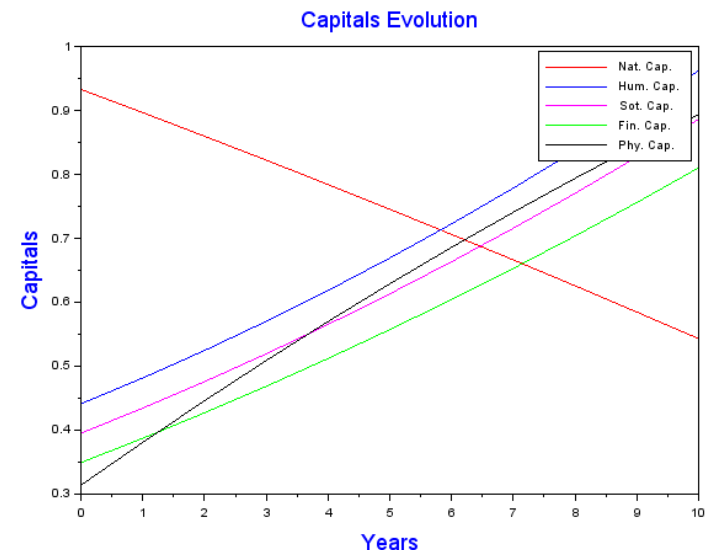
Figure 4. Capital evaluation equations.